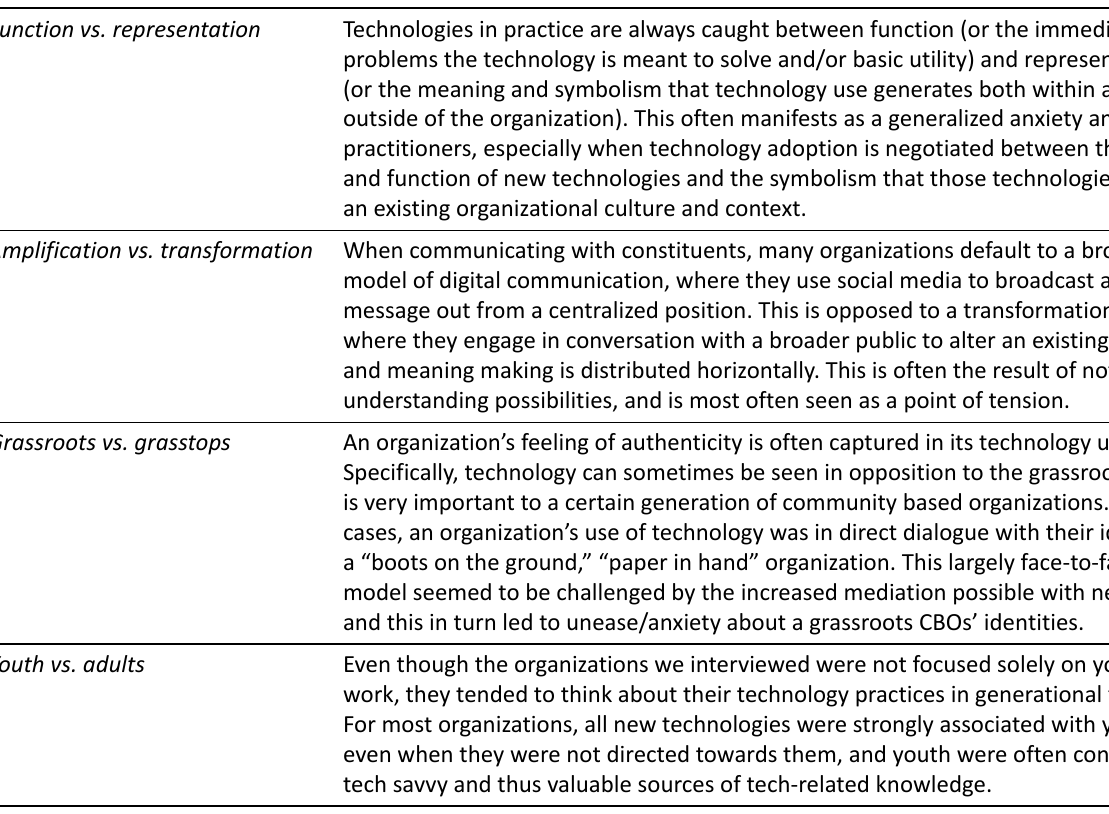
Table 2. Description of tensions. Function vs.